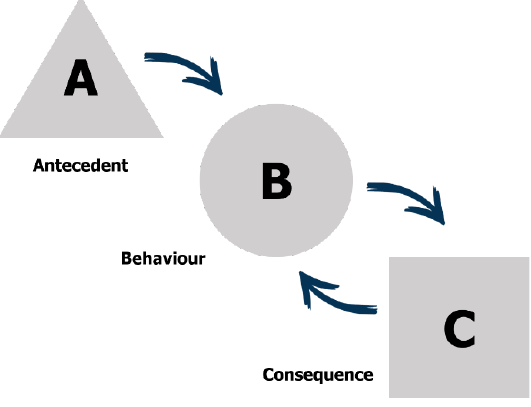
Figure 1 . ABC Model (adapted from Meadan et. al.